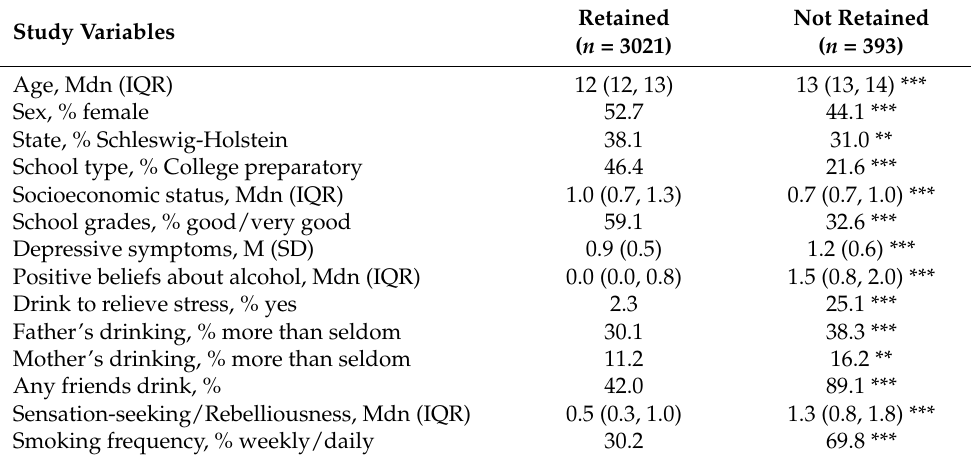
Table 1. Baseline characteristics of participants retained and not retained for